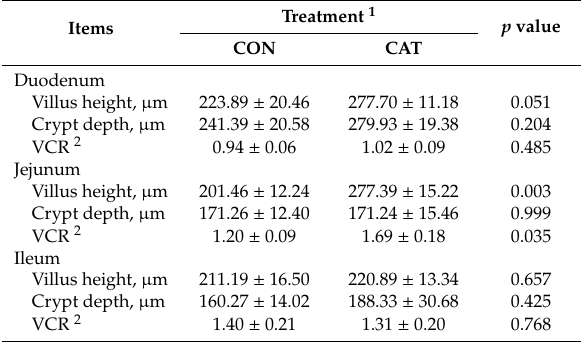
Table 2. E ff ects of dietary exogenous catalase supplementation on intestinal morphology in weaned piglets.